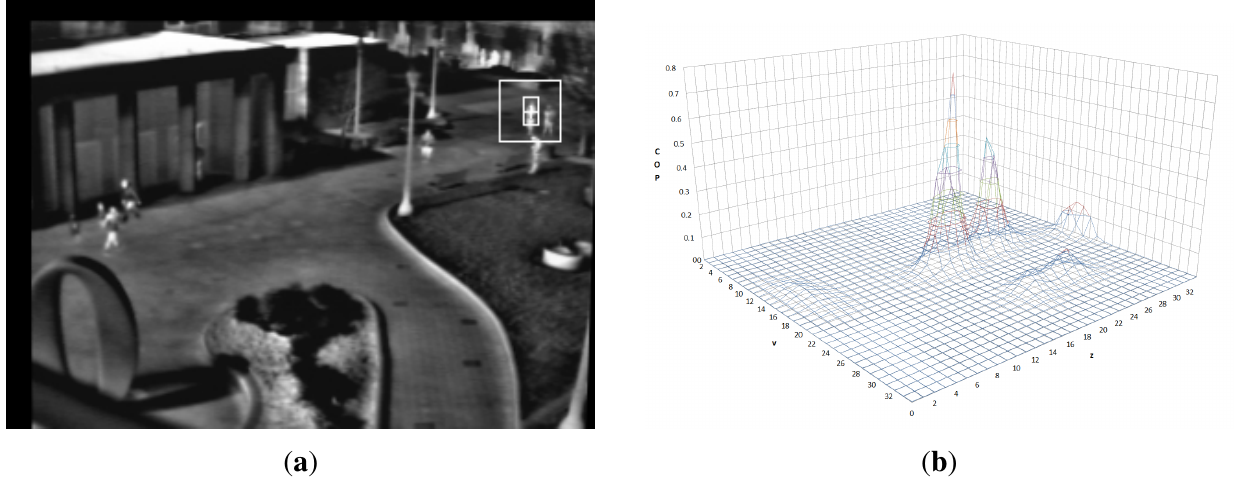
Figure 1. Processing of the intensity variation function (IVF) algorithm in a sample frame from the OTCBVS (Object Tracking and Classification Beyond the Visible Spectrum) dataset [24] (sequence otcbvs 03-l1s2ir-4). ( a ) Frame 57; ( b ) correlation output plane (COP) of Frame